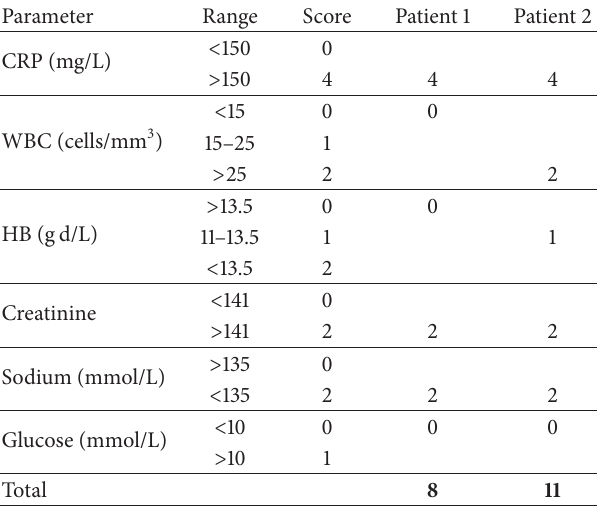
Table 2: LRINEC scoring for patient 1 and patient 2. The table is modified from Wong et al., 2004